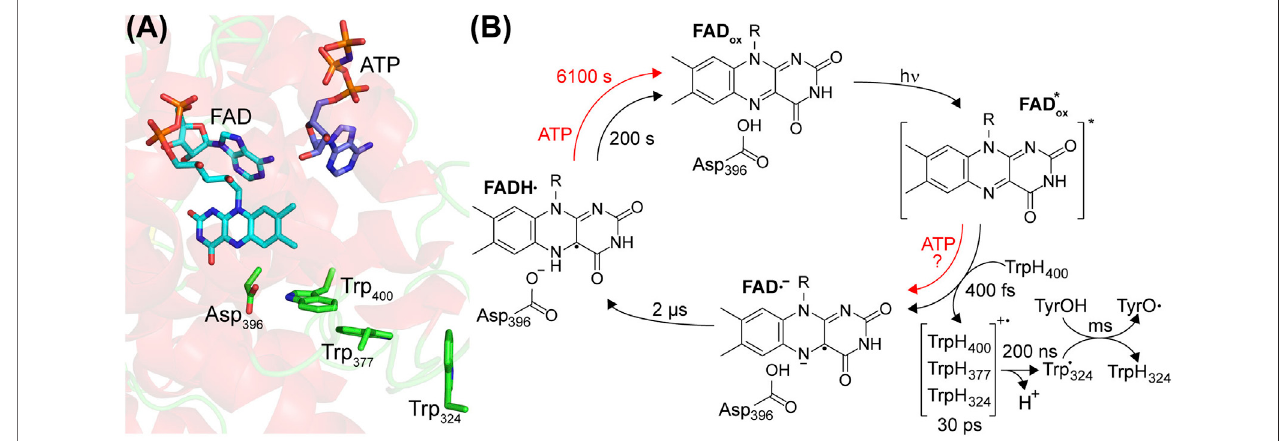
FIGURE2| CenterofthephotoreactionofplantcryptochromesandphotocycleofFAD. (A) The α -helicaldomainofthePHRbindsoxidizedFADandATP.Closeto theFAD,atryptophan-triadTrp 400 ,Trp 377 andTrp 324 actsaselectrondonorandasparticacidAsp 396 actsasprotondonor(accordingto At CRY1numbering). (B) FAD ox isexcitedbyUV-A/bluelightinitiatinganultrafast electrontransferfromTrp 400 .InthepresenceofATP,analternativeelectron pathwayhasbeenproposed.Theresulting (cid:129) − FAD anion radical (FAD ) is stabilized by electron hopping events in the tryptophan triad and deprotonation of TrpH 324 (cid:129) − (cid:129) protonates FAD to the FAD neutral radical (FADH ), which represents the signaling state. The formation of a tyrosyl radical (TyrO region. Binding of ATP enhances the yield of the photoreaction and decelerates the reoxidation to FAD ox as indicated by the time constants determined for Cr pCRY.